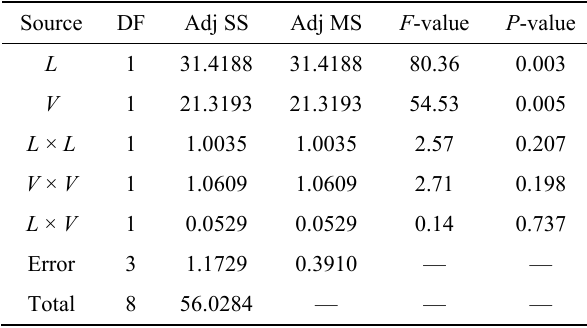
Table 9 Analysis of variance for S k .